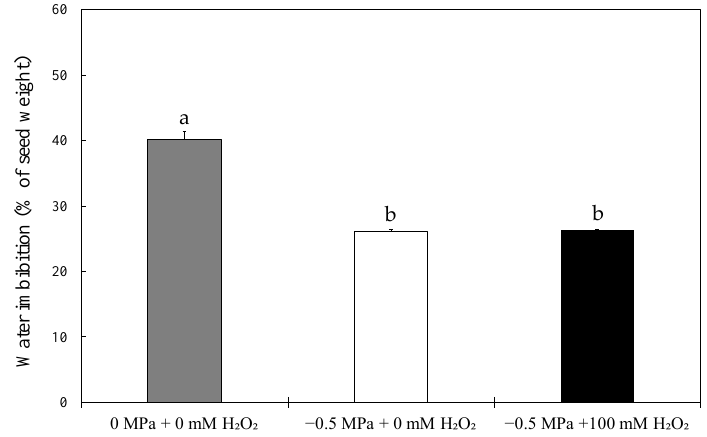
Figure 2. Effect of hydrogen peroxide treatment on the water absorption percentage of seeds at 24 h after imbibition under different water potentials. Seeds were imbibed with distilled water (0 MPa) without H 2 O 2 and PEG solution ( − 0.5 MPa) with or without 100 mM H 2 O 2 . Columns with the same letters are not significantly different between treatments by Tukey’s test ( p < 0.05).